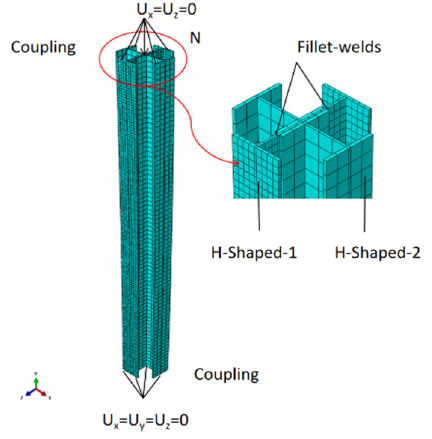
Figure 4. The finite element model of FCHCs.